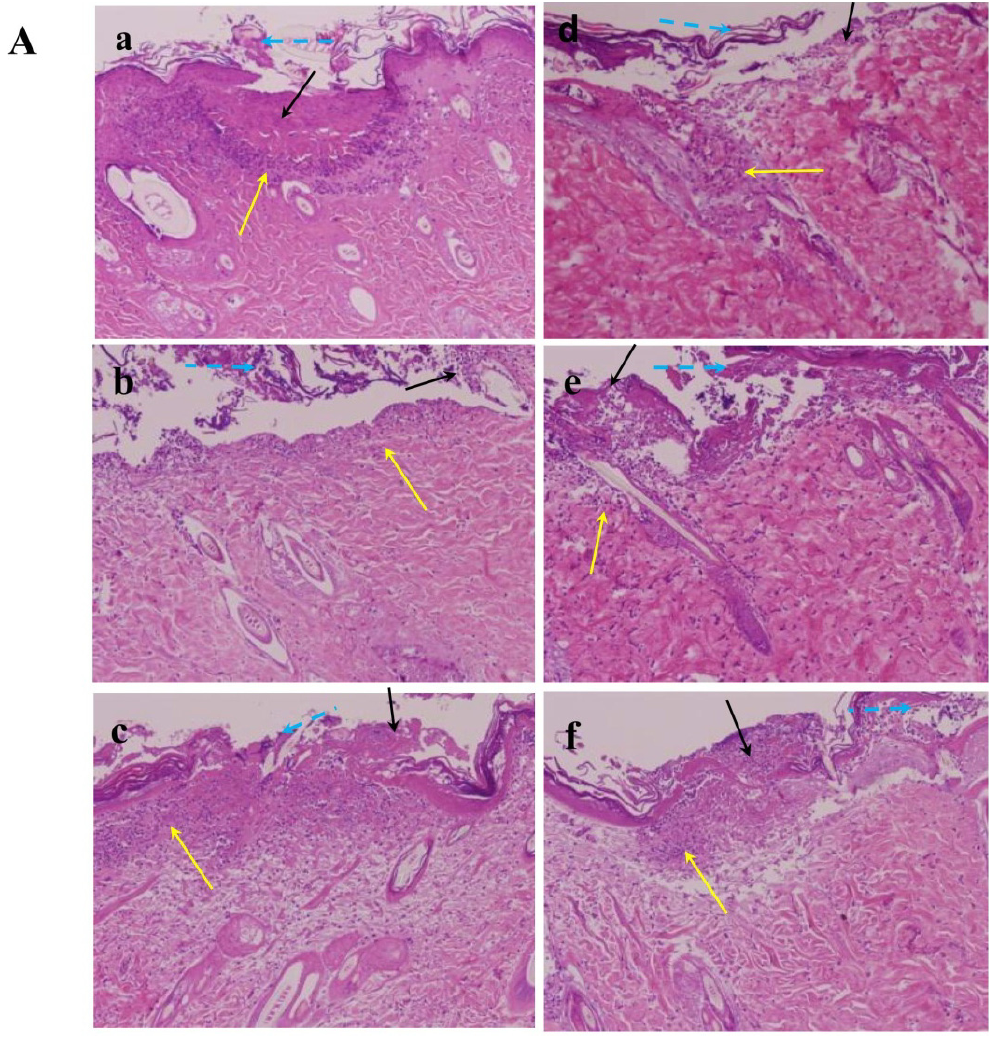
Figure 6. Histological features of the burn wounds on ( A ) day 3 and ( B ) day 13 after topical treatment with untreated controls (C) ( a ), silver sulfadiazine 1% cream (positive controls, PC) ( b ), Vaseline (vehicle) ( c ) and various concentrations of Nac (0.1%, 0.5%, 3.0%) ( d – f ). Yellow arrows indicate acute inflammation; black arrows indicate necrotic tissue; blue dashed arrows indicate peeling of epithelial tissue; red arrows indicate collagen formation; yellow dashed arrows indicate crust; blue arrows indicate regenerated epidermis. Photos shown are all representative of three independent experiments done in duplicate. The images in ( A ) and ( B ) show the original magnification